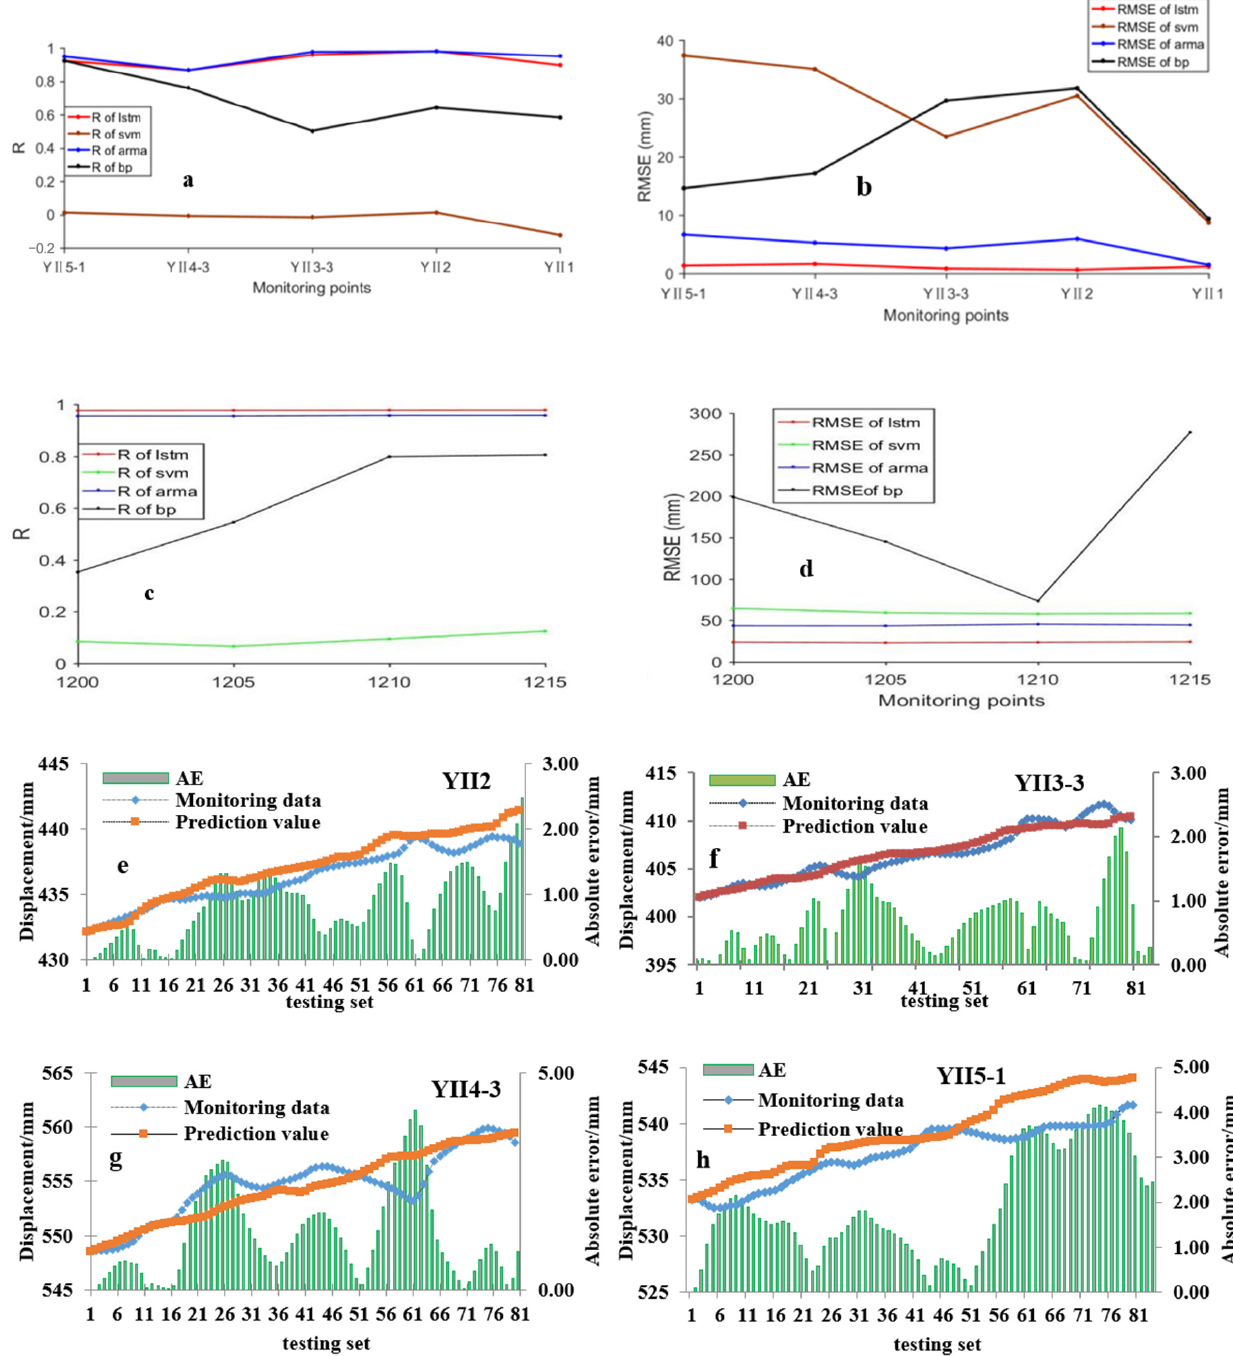
Figure 16. Accuracy evaluation of the different model forecasts. ( a ) Regression coefficient R of surface displacement. ( b ). Root mean square error RMSE of surface displacement. ( c ). Regression coefficient R of different inclinometer. ( d ). Root mean square error RMSE of different inclinometer. ( e – h ) absolute error of LSTM model of different monitor stations.